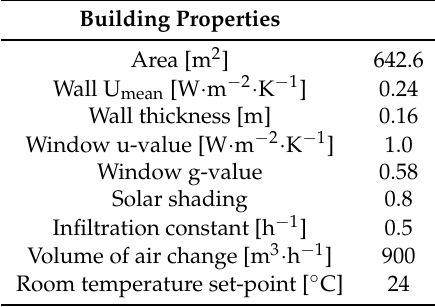
Table 3. Main hotel properties in TRNSYS.